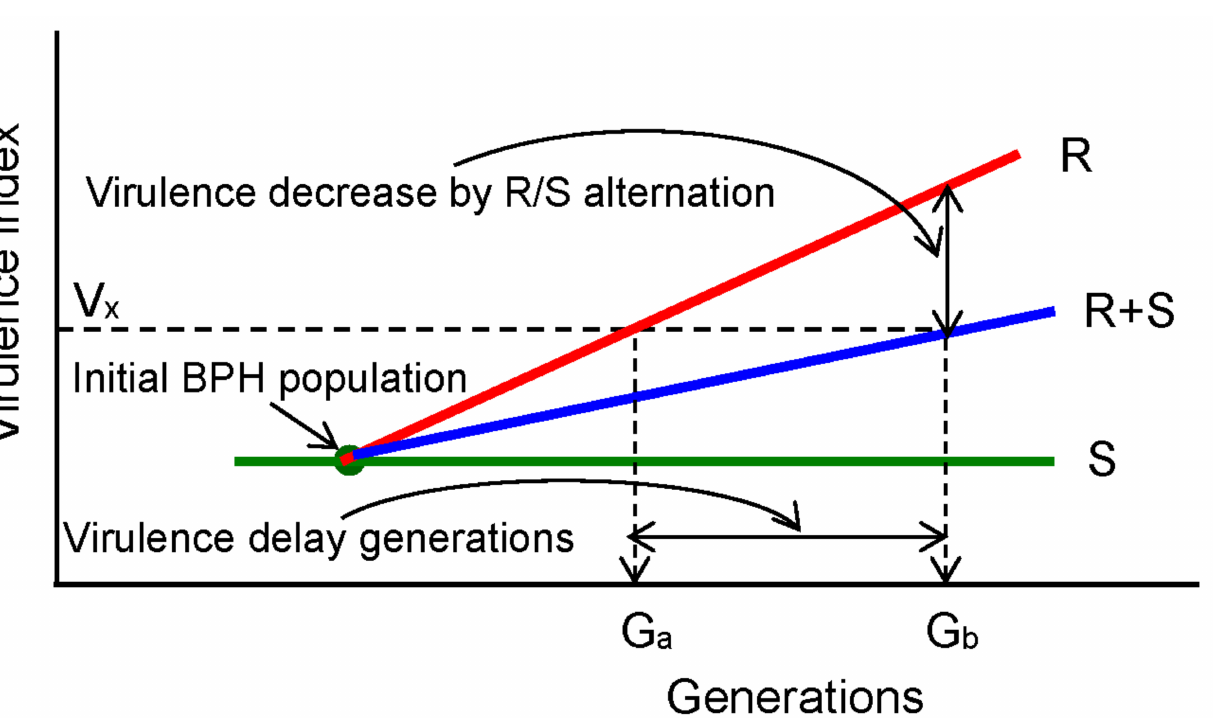
Figure 4. Summary of the variation in BPH virulence while rearing with highly resistant rice varieties ®, susceptible rice varieties (S), and a mixture of resistant and susceptible rice varieties (R + S). Because the virulence of the BPH increases if it is reared with highly resistant rice varieties, V x shows any value of virulence index higher than that of the initial BPH population. G a indicates the number of generations required by the initial BPH population fed on a single highly resistant rice variety for its virulence index to reach Vx. G b indicates the number of generations needed by the initial BPH population reared alternately with highly resistant rice varieties and a susceptible rice variety for its virulence index to reach V x . Virulence delay generations indicates the generations’ G b minus G a . The virulence decrease by the H/S mixture indicates that the virulence index increased after the susceptible rice variety was included as an alternative highly resistant rice